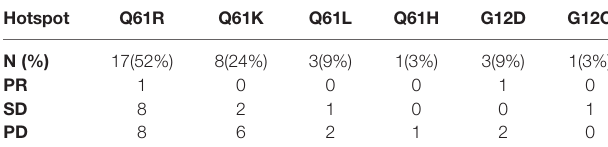
TABLE 3 | Ef fi cacy of immunotherapy by NRAS mutational hotspot.